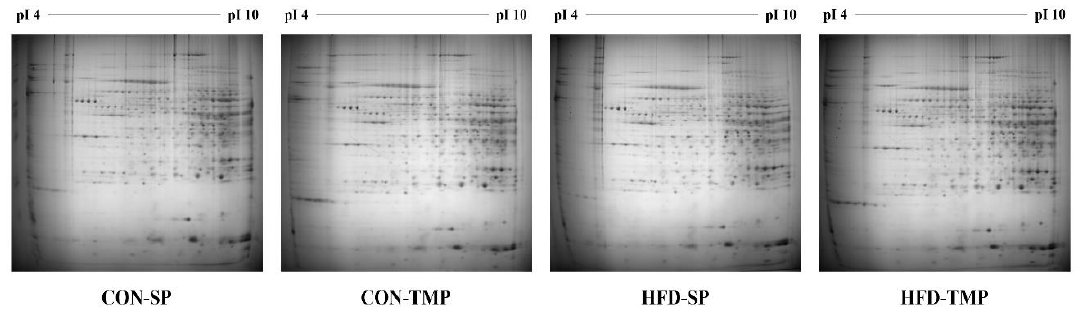
Figure 5. Two-dimensional electrophoresis patterns of the proteins in the liver.